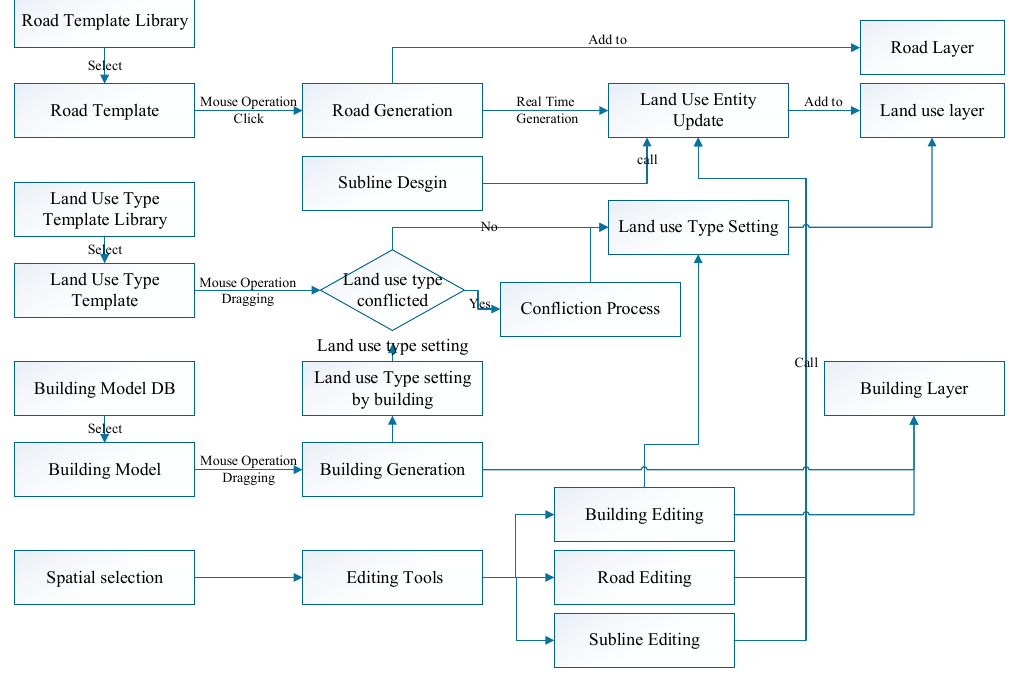
Figure 4. The framework of interactive landscape design.